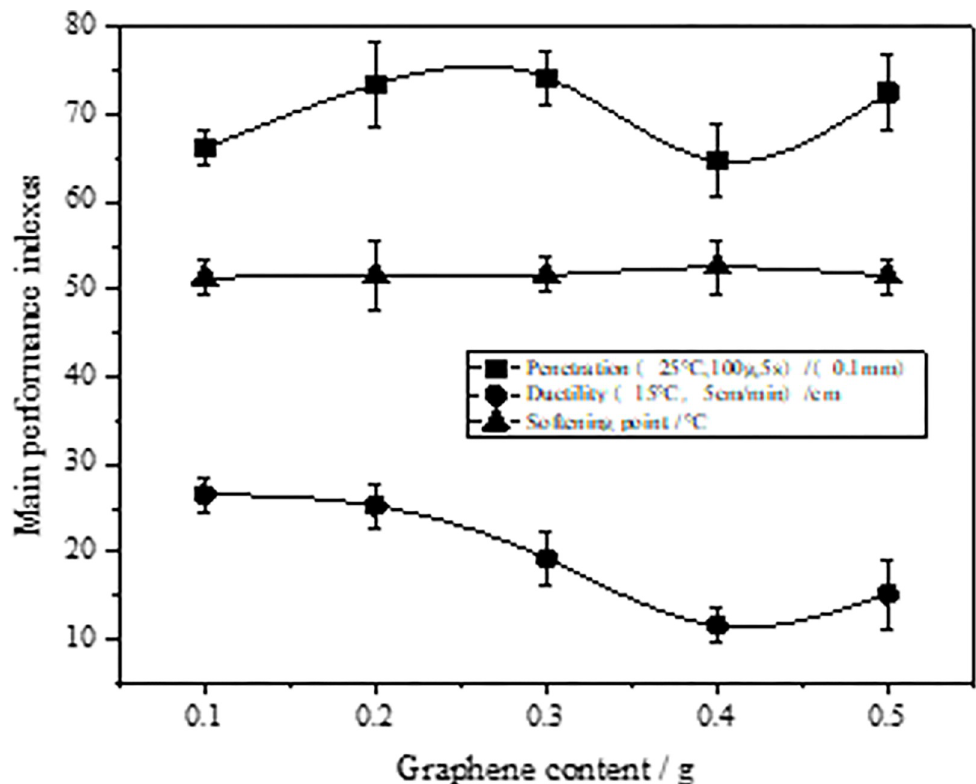
Fig 4. Relation between asphalt binder’s main performance indices and graphene